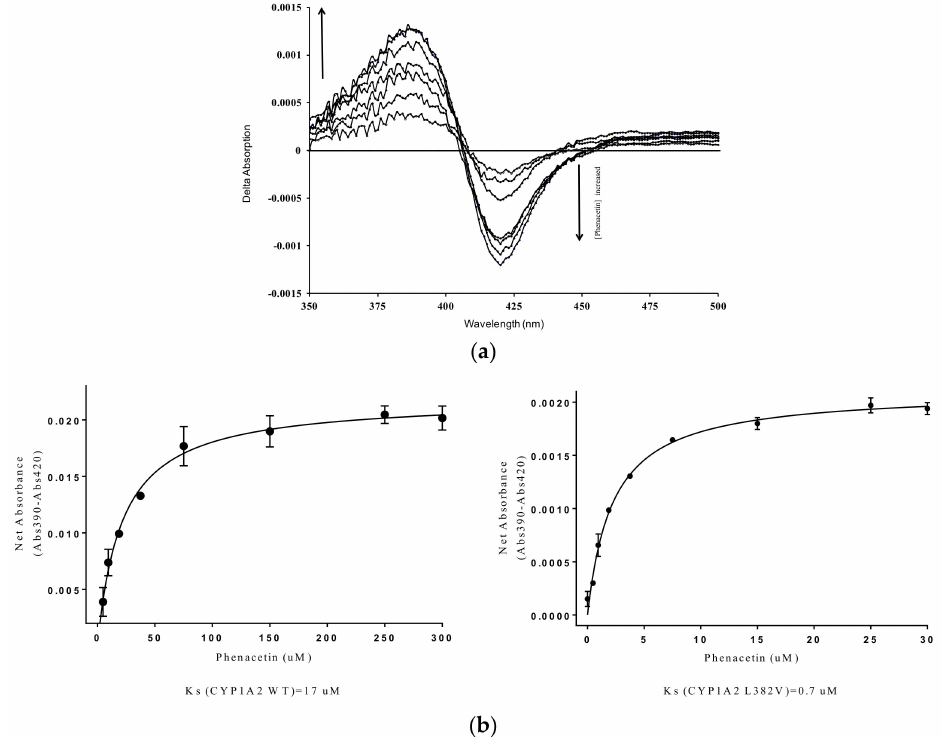
Figure 2. Phenacetin binding determined for CYP1A2 wild type (WT) and the mutants by ultraviolet/visible (UV/Vis) spectroscopy. ( a ) Spectral binding curves for phenacetin bound in CYP1A2 L382V. A type I spectrum is evident with a peak at ~390 nm and a trough at ~420 nm. CYP1A2 WT, N312L and L382V/N312L have similar UV/Vis binding spectra (not shown); ( b ) Binding curves for phenacetin in CYP1A2 WT and the L382V mutant and the K S values derived from fitting of the data to Equation